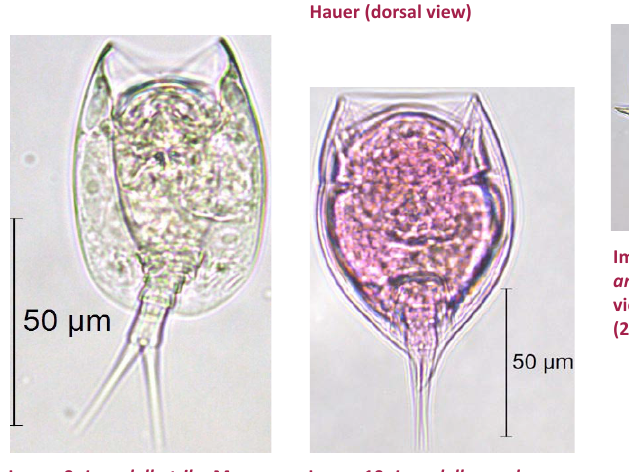
Image 9. Lepadella triba Myers (ventral view)